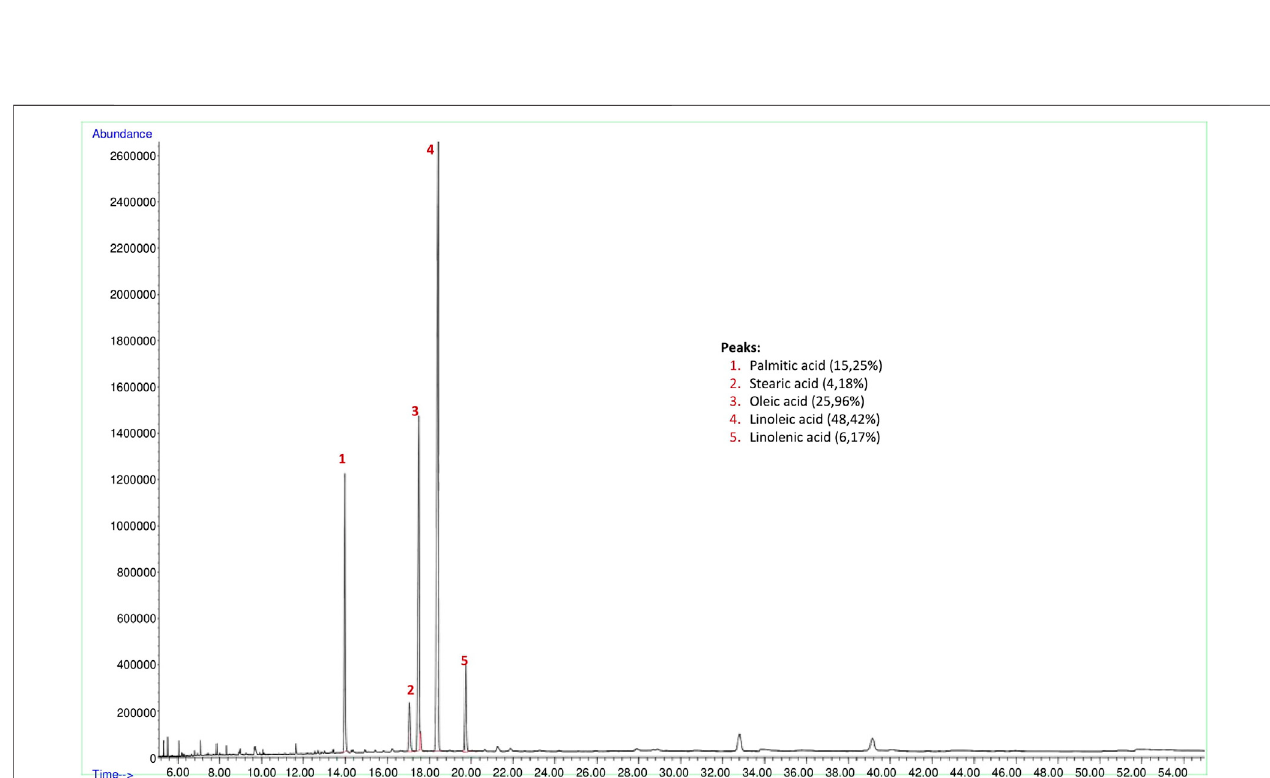
FIGURE 3 | GC-FID chromatogram of hexane extract of psyllium ( Plantago ovata ) seed.